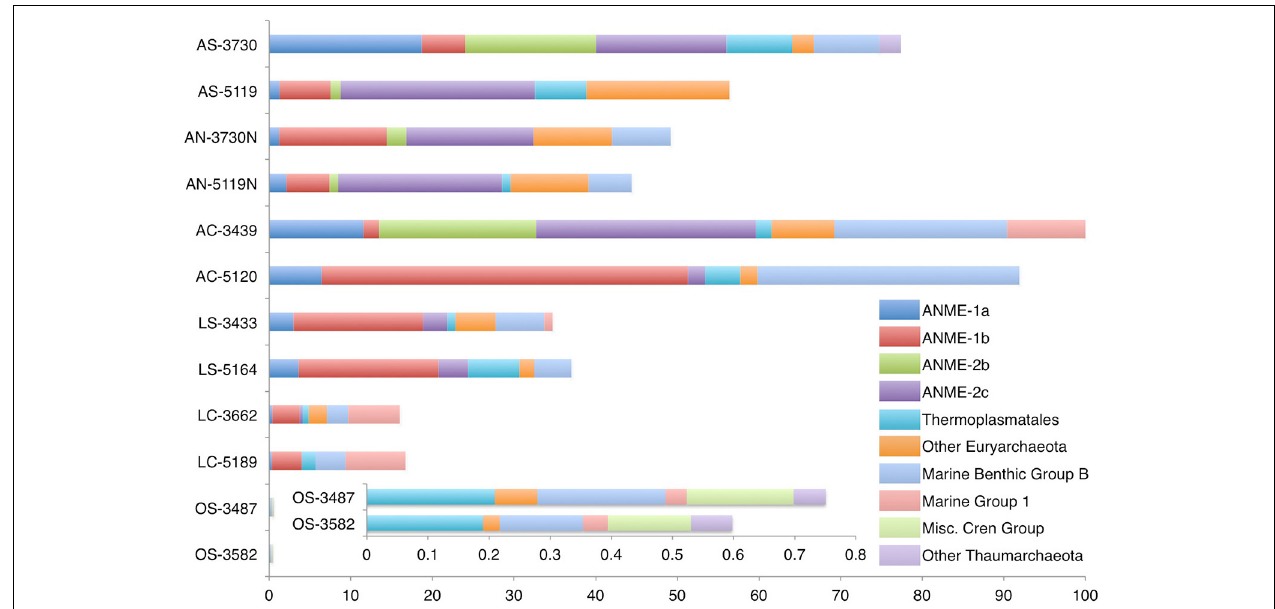
FIGURE 2 | Distribution of archaeal 16S rRNA gene sequences recovered from carbonate, nodule and sediment samples. Phylogenetic groups that account for at least 20% of overall abundance in one or more samples are shown. In all cases, bar lengths are scaled by the microbial abundance observed in each sample, with AC-3439, which has the highest microbial